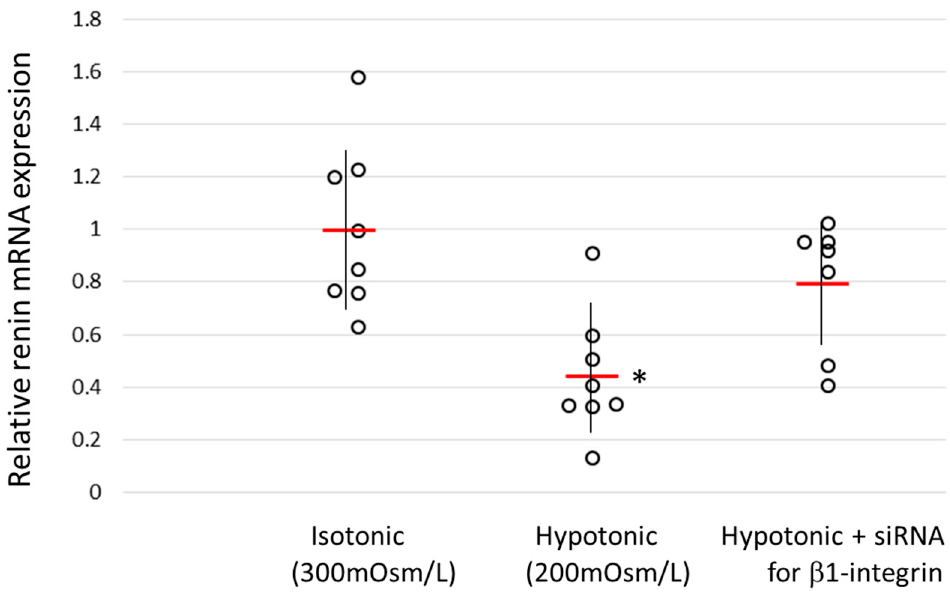
Figure 4. Effect of hypotonic medium on renin expression in a juxtaglomerular cell line (As4.1 cells). As4.1 cells were cultured in hypotonic medium (200 mOsm/L). After 24 h, the renin expression was examined by qRT-PCR. Control cells were cultured in isotonic medium (300 mOsm/L). Some were cultured in hypotonic medium after β 1-integrin knockdown with siRNA (Hypotonic + siRNA for β 1-integrin). Data were represented by scatter plot with average (red bars) and SD (black vertical lines). Asterisks indicate significant differences ( p < 0.05) from the control (Isotonic).